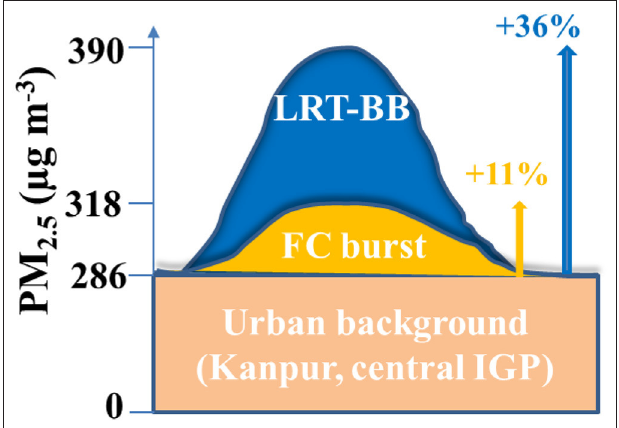
FIGURE 7 | Sources contributions schematic (deduced from Lenschow-type analysis) over an urban agglomeration (Kanpur) in central Indo-Gangetic